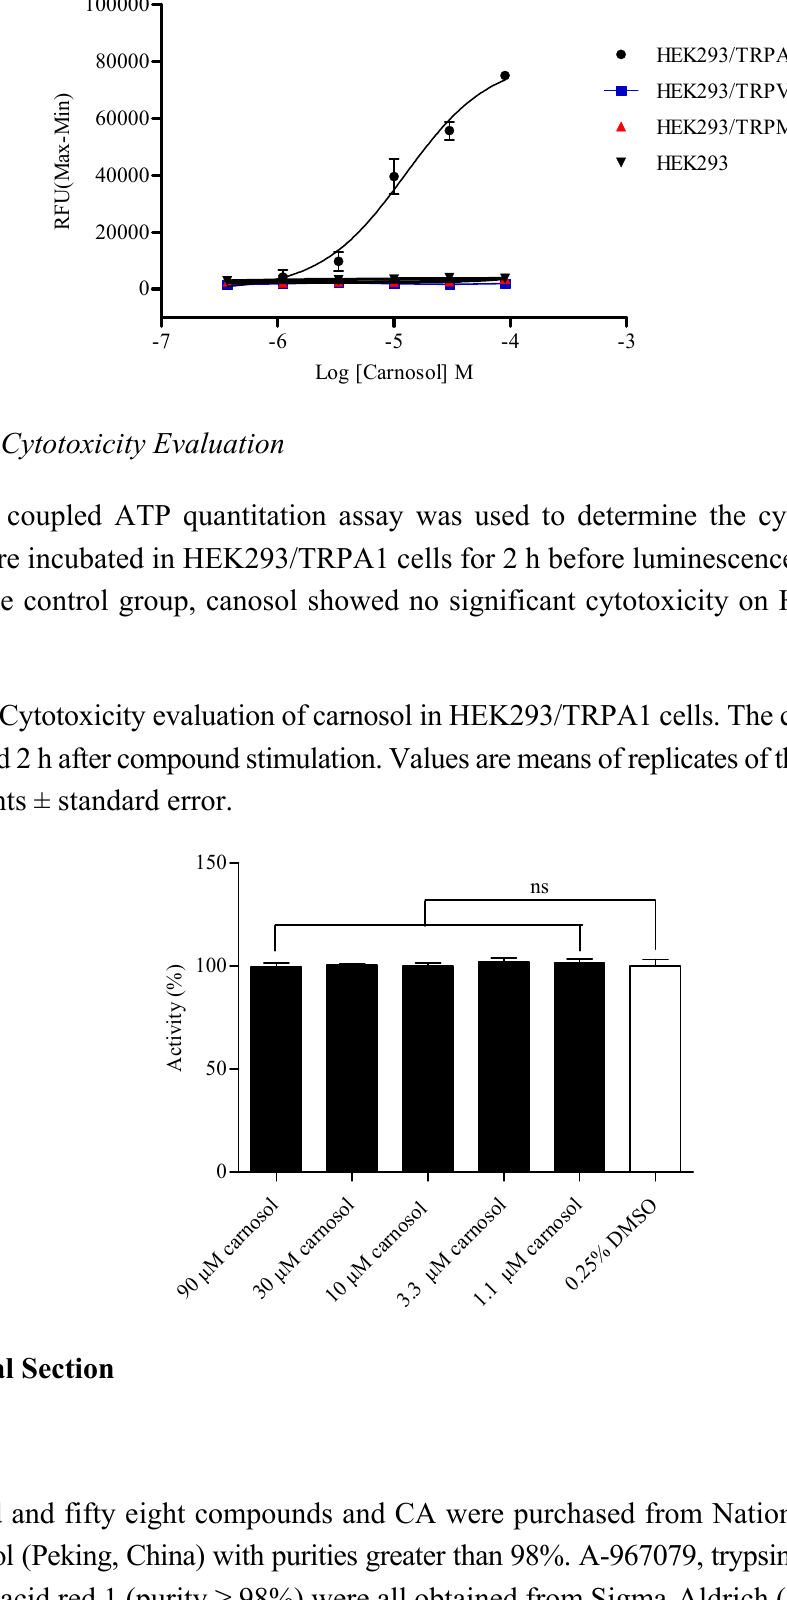
Figure 8. Differential effects of carnosol on TRPA1, TRPM8 and TRPV3 receptors. Serious concentrations of carnosol were tested in host HEK293 and three recombinant cell lines using calcium mobilization assay, respectively.